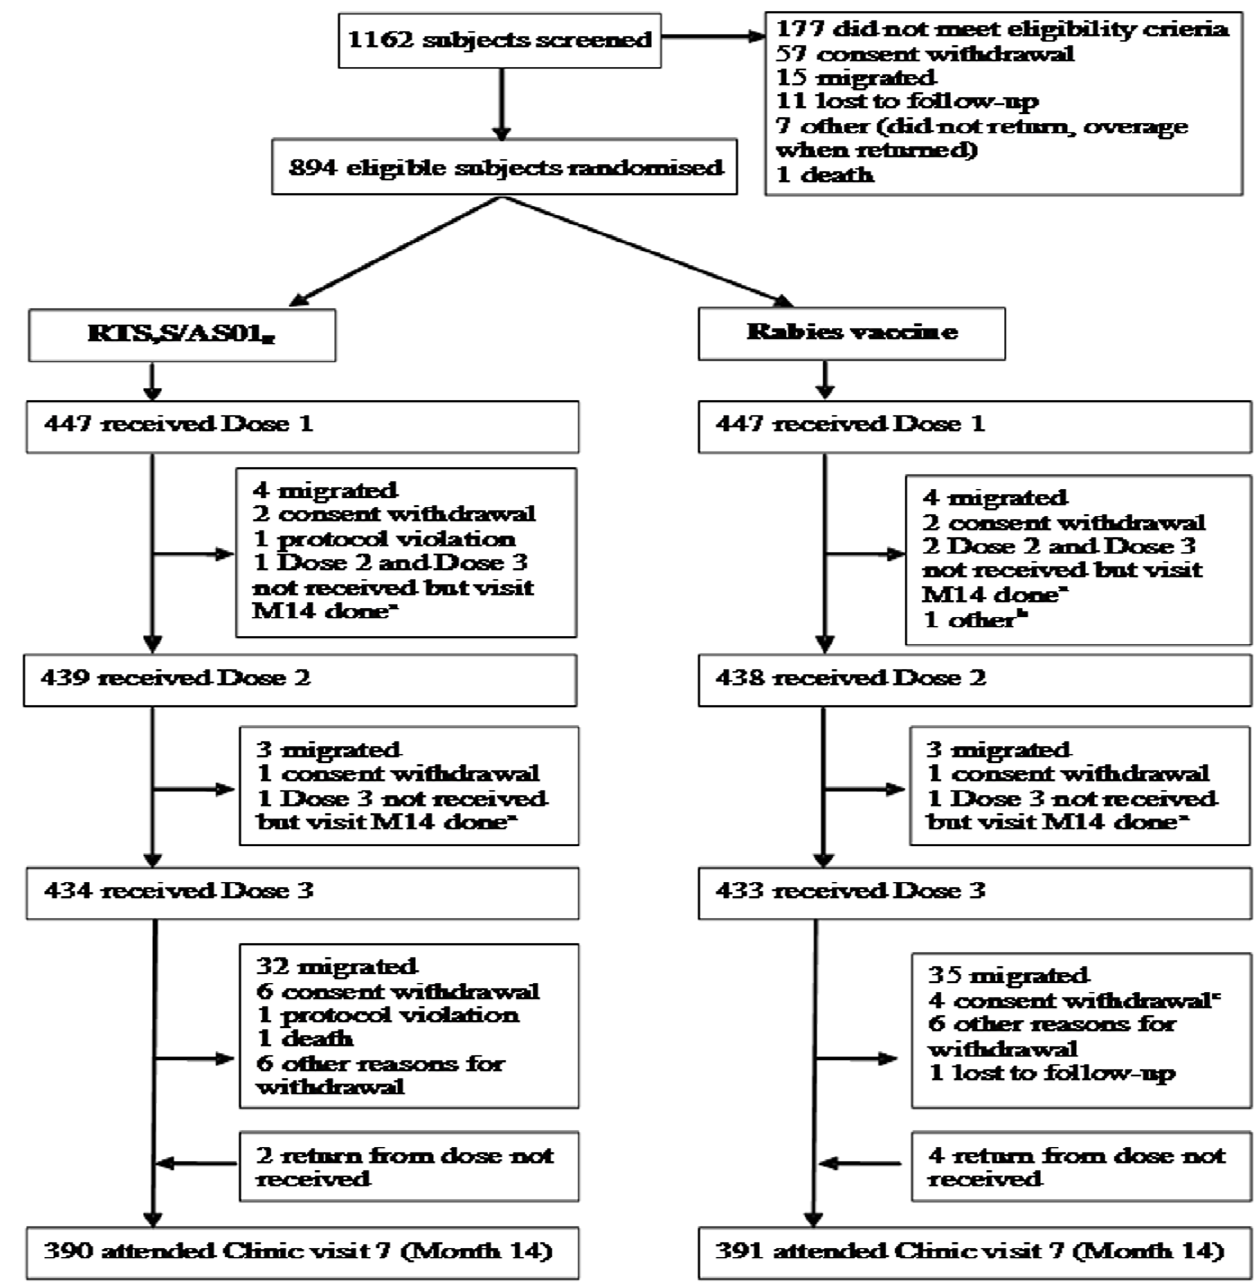
Figure 2. The assembly and disposition of study participants. a Subjects were temporally out of study area but returned for Month 14 (M14) visit. b Investigator decided not to continue vaccination as EPI vaccination documentation was not available, this subject returned for Month 14 (M14) visit. c One subject died after consent withdrawal.